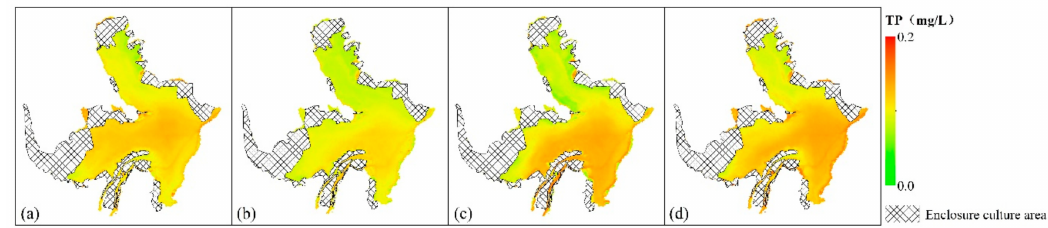
Figure 4. The seasonal average of the TP concentration from 2016 to 2018 in Lake Hongze in each season: ( a ) Spring; ( b ) summer; ( c ) autumn; ( d )